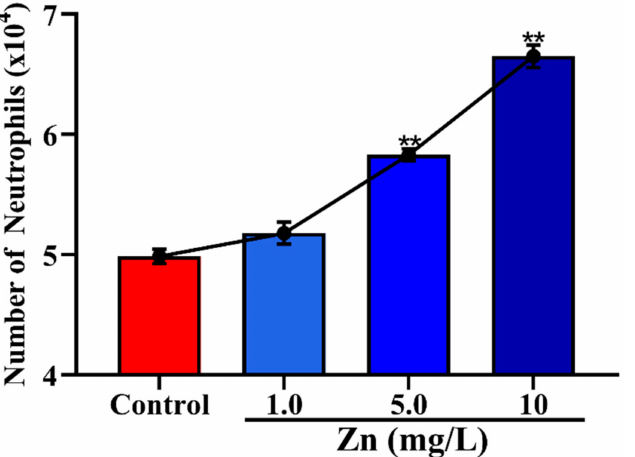
Figure 4. Effects of Zn on the migration of neutrophils in the trans-mammary epithelium. ** p < 0.01 between the different concentrations of Zn (1.0, 5.0 and 10 mg/L) group and the control group in the same batch. Each value represents the mean ± SEM, n = 6.